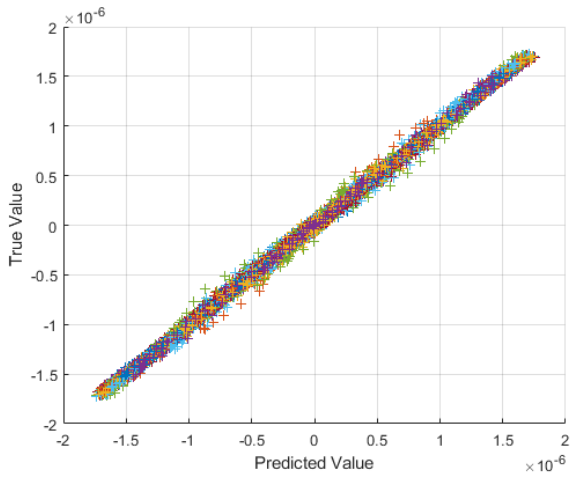
Figure 4. True values versus predicted values of the torque profile.